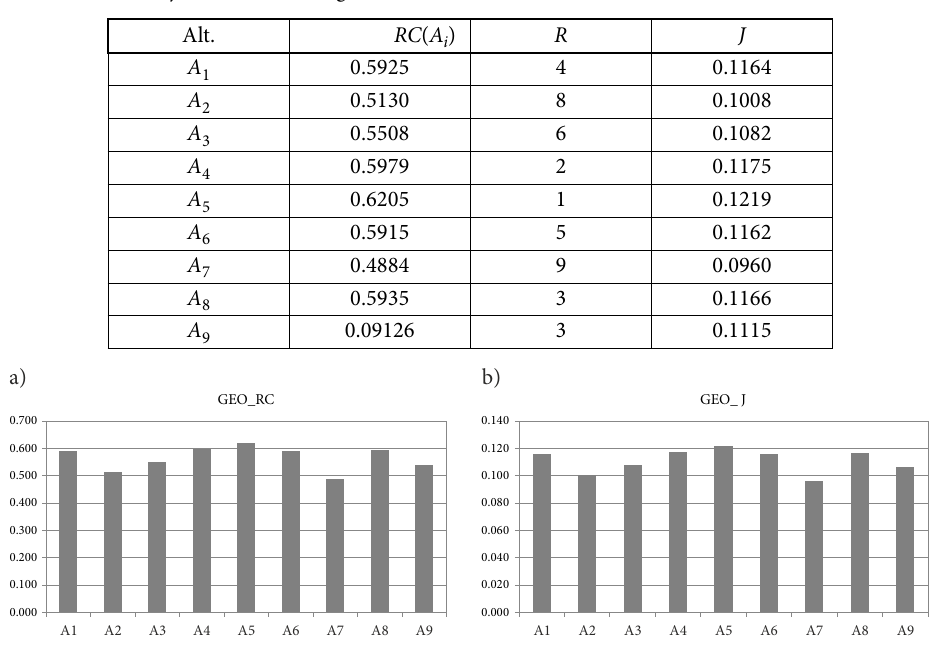
Figure 7. Rankings of gerontechnologies after using the aggregation operator (19) with objective criteria weights based on a) RC ( A i ) , b) J